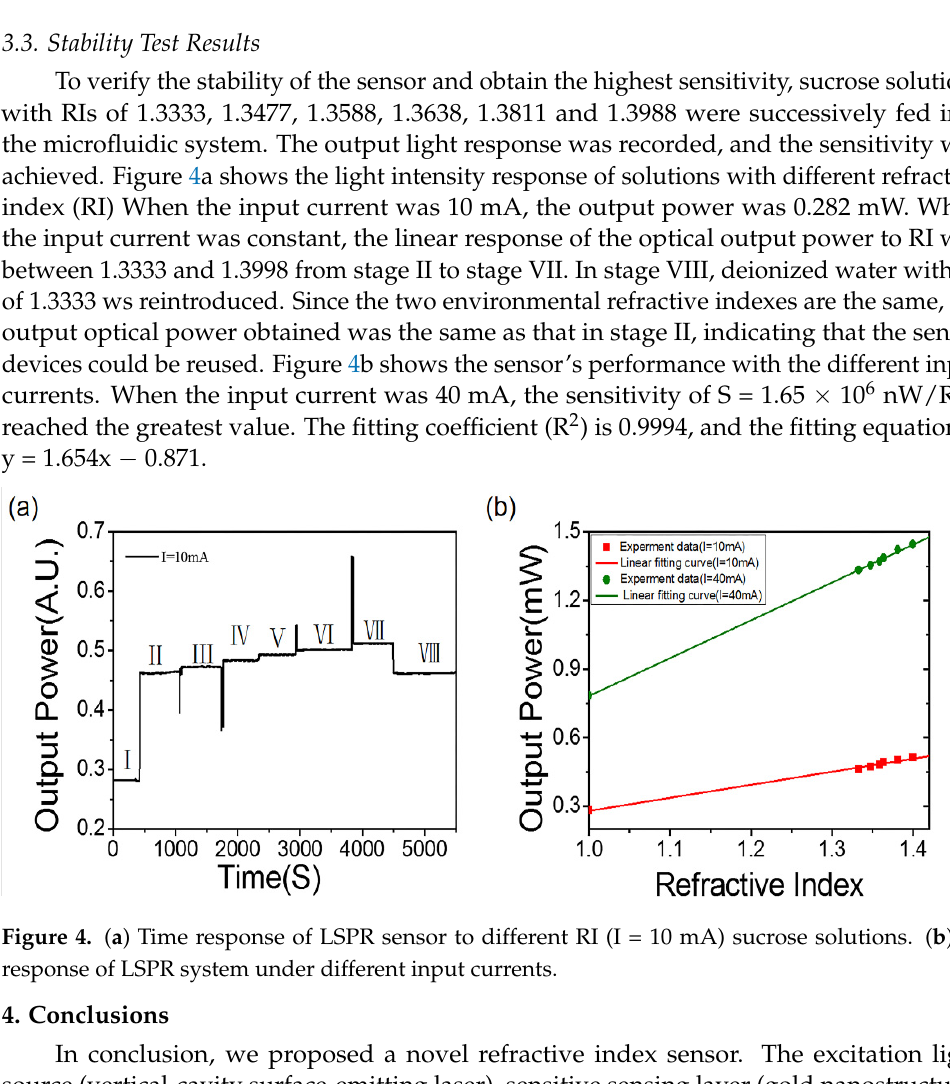
Figure 3. ( a ) P-I-V characteristics of sensor under different conditions. ( b ) Sensitivity curve of sensor and air environment.